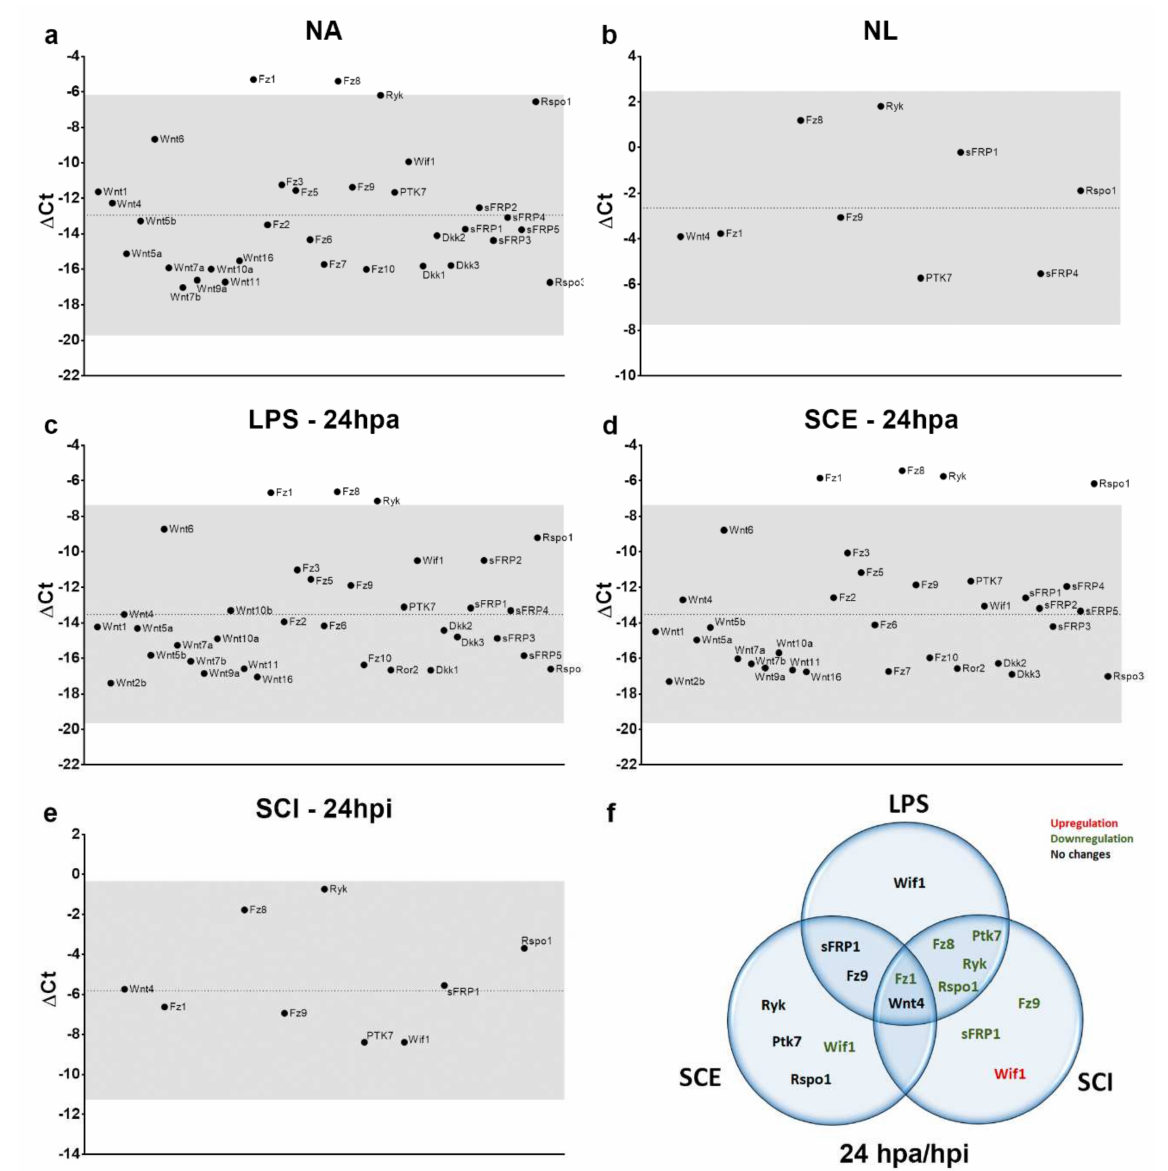
Figure 6. Schematic overview of harmful stimulus effect on microglial cells both in vitro and ex vivo for the three experimental conditions that were evaluated at 24 h post-treatment/injury. Graphic representation of ∆ Ct values for the different genes that were analyzed in the different evaluated conditions, where the dashed line indicates ∆ Ct mean value in each case and gray shading identifies an area corresponding to the mean value ± 2 times the standard deviation to highlight those genes with higher/lower expression levels for each experimental condition. ( a ) Wnt-related genes that were detected in non-activated microglial cells in vitro, ( b ) Wnt-related genes that were detected in microglial cells isolated from non-lesioned spinal cord, ( c ) Wnt-related genes that were detected in LPS-activated microglial cells in vitro at 24 hpa, ( d ) Wnt-related genes that were detected in SCE- activated microglial cells in vitro at 24 hpa, ( e ) Wnt-related genes that were detected in microglial cells that were isolated from injured spinal cord at 24 hpi, ( f ) Venn diagram shows individual and shared gene alterations that were observed for the three experimental conditions that were evaluated at 24 h post-activation/injury. NA: non-activated; NL: non-lesioned; LPS: lipopolysaccharide; SCE: spinal cord extract; SCI: spinal cord injury; hpa: hours post-activation; dpa: days post-activation; hpi: hours